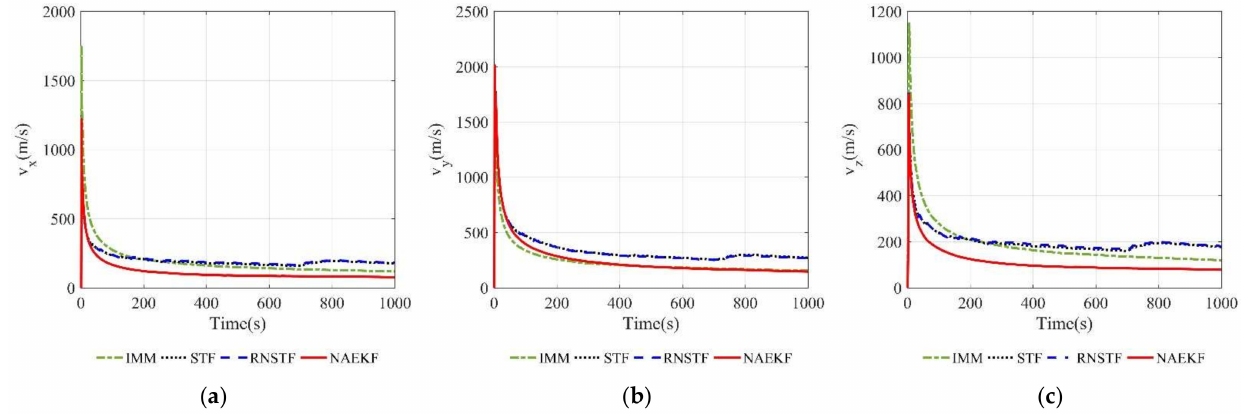
Figure 22. σ -Boundary of velocity estimation errors. ( a ) σ -Boundary of v x ; ( b ) σ -Boundary of v y ; ( c ) σ -Boundary of v z .